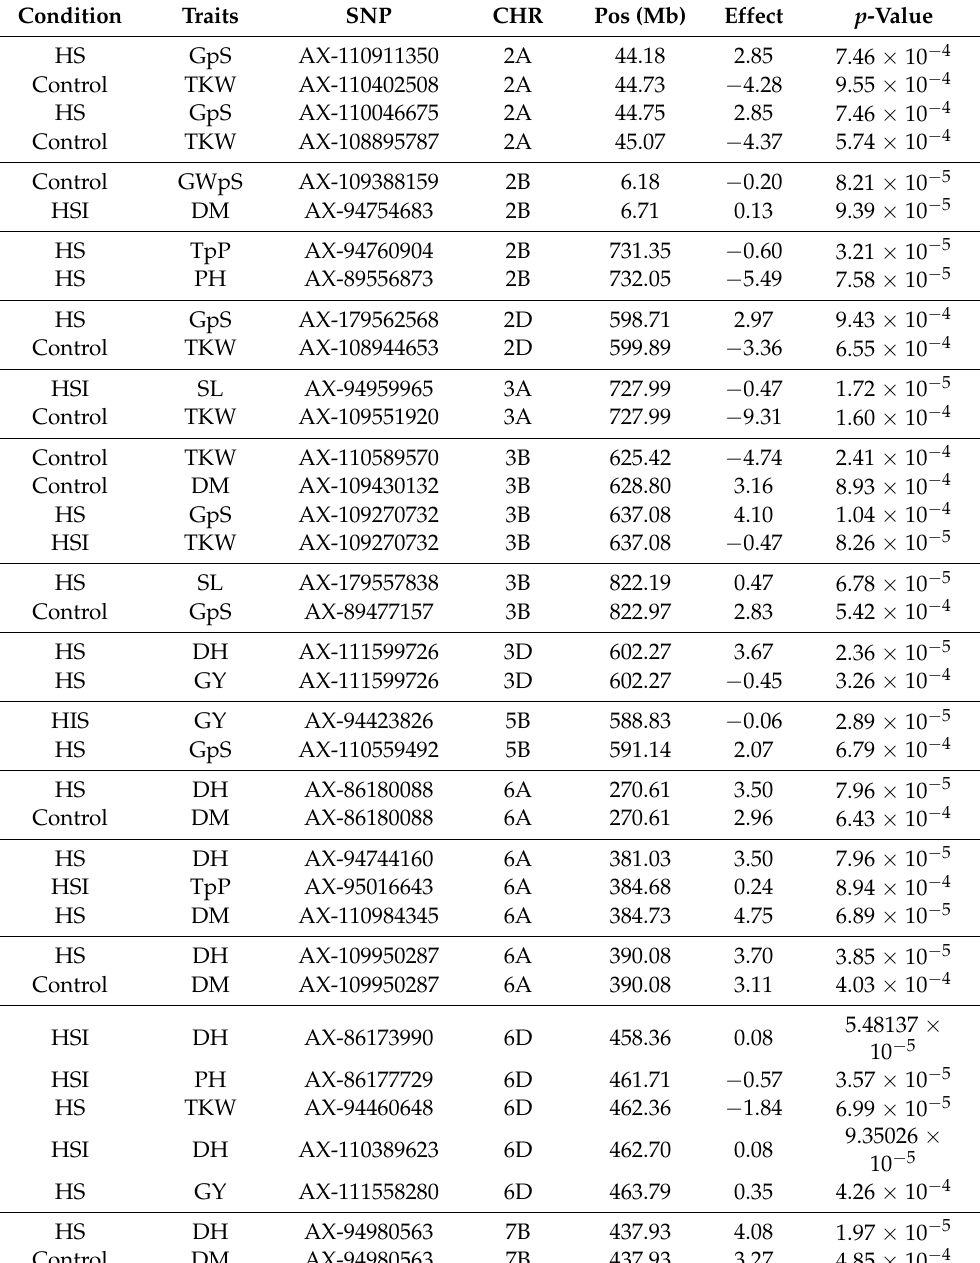
Likewise, the QTNs associated with multiple traits were designated as pleiotropic QTNs (Table 3). In total, 14 pleiotropic QTNs were identified, out of which 3 QTNs on chr2D, chr3D, and chr6D were contributed by the D-sub genome and may carry novel alleles from Ae. tauschii . A QTN on chr2A at ~44 Mb was associated with GpS and TKW under both HS and control conditions. Another QTN on chr3D was associated with DH and GY and could be an important locus because plants tend to flower early to escape heat stress, and simultaneous control of such traits is an important finding. Table 3. Pleiotropic QTNs associated with various yield traits under control, heat susceptibility index (HSI) and heat stress (HS) conditions, with chromosome number, position (Mb), effect, and p -value. Condition